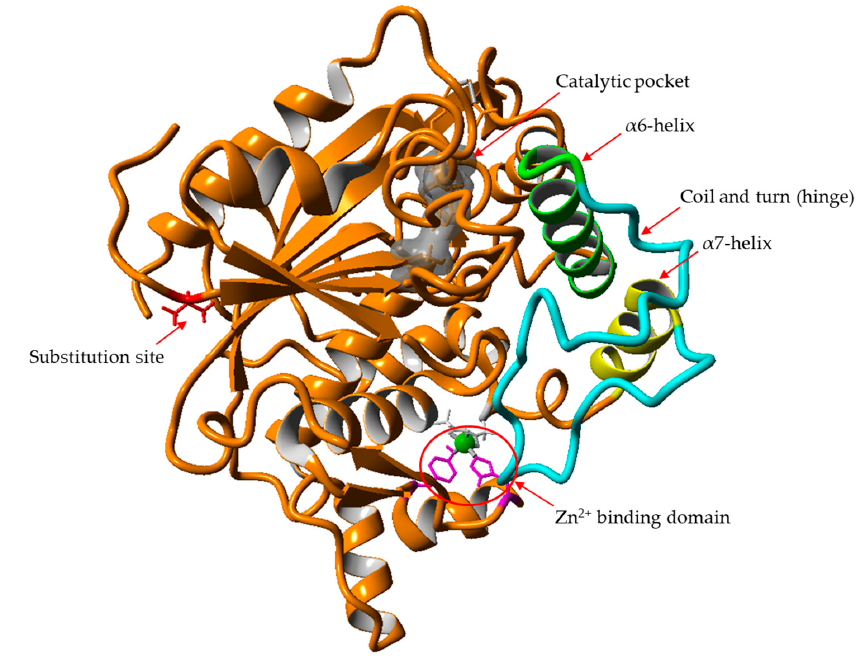
Figure 4. The relative position of the affected local structures with the substitution site in A8V.The flexibility of one of the lid helices α 7 (yellow) and the coil and turn hinge (blue) increased upon substitution with valine at the critical point. The affected structures and the α 6-helix lid (green) are involved in the interfacial activation mechanism. The affected Zn 2+ binding domain is shown in magenta. Also shown is the catalytic pocket (grey) and the substitution site (red).